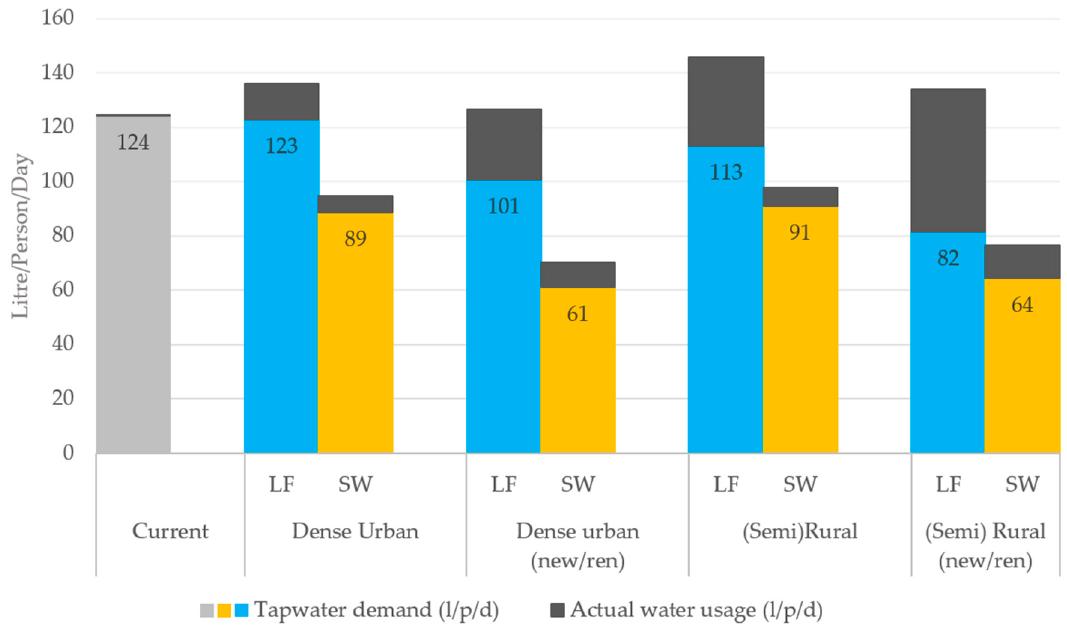
Figure 4. (Tap)water demand in litres per person per day (L/p/d) for both LF-extreme and SW-